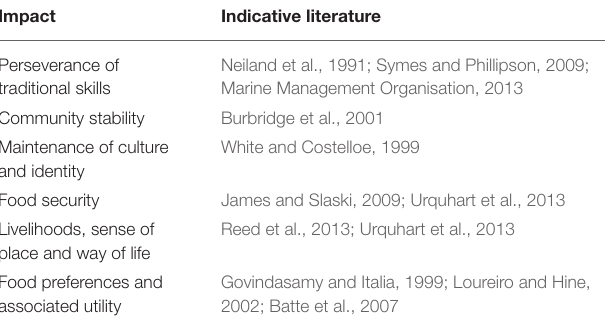
TABLE 1 | Social impacts of aquaculture.